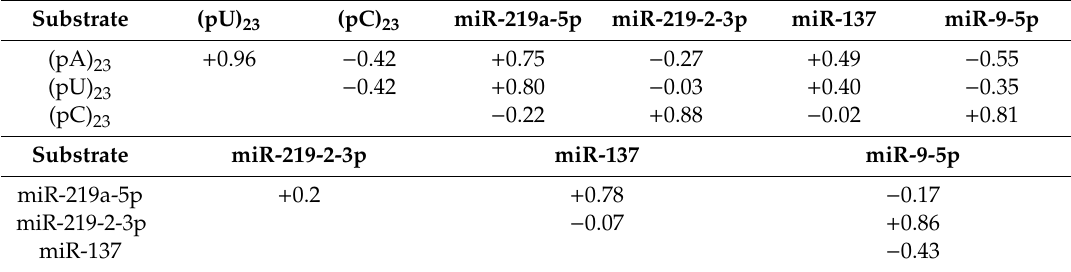
Table 1. Values of coe ffi cient correlations between the RAs of seven IgGs in the hydrolysis of miRNAs and